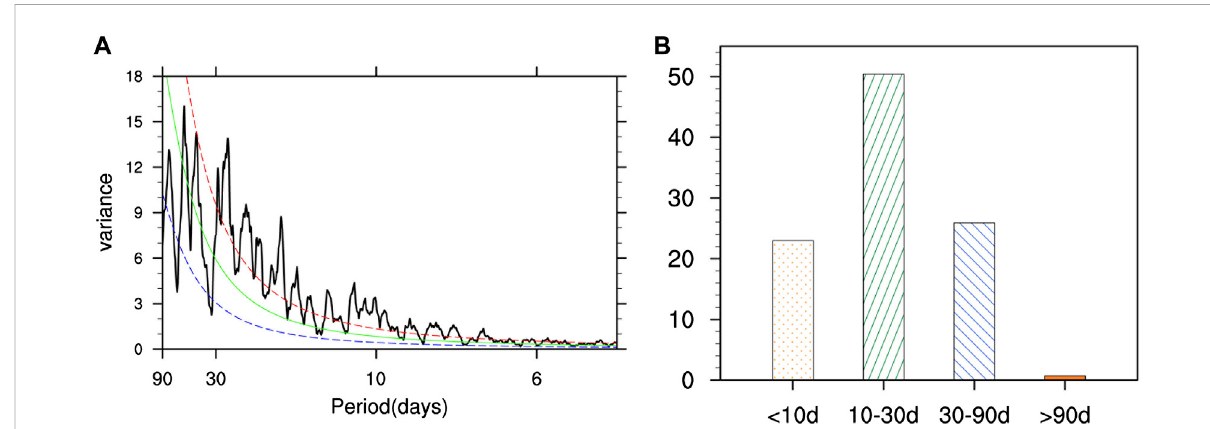
FIGURE 4 (A) Power spectrum analysis ofgeopotential height anomaly overthemid-high-latitude keyregion during Mayto July (unit: W 2 m − 4 ).The green dashedlineistherednoise spectrum,andthered(blue)dashedlineindicates valuesabovethe95% (5%)con fi dencelevel. (B) Variation contributions of the perturbations at different time scales (unit: